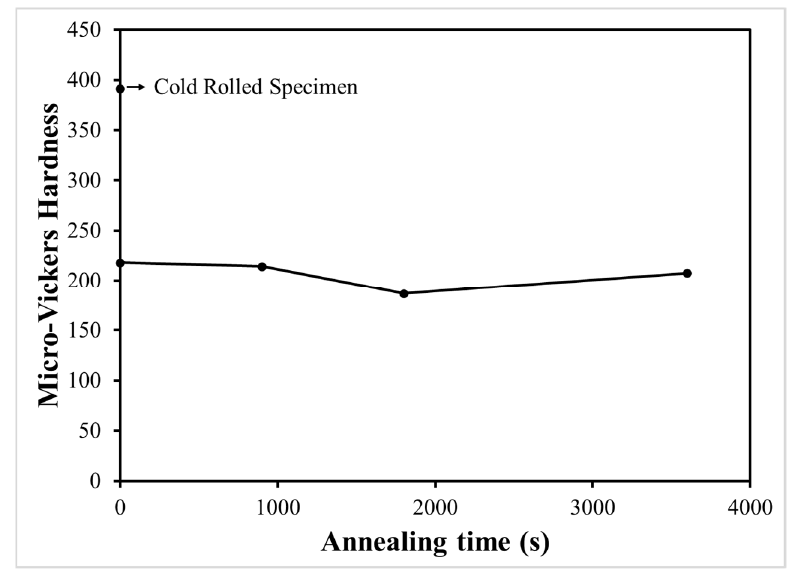
Figure 7. Effect of annealing time on the value of the micro-Vickers hardness.